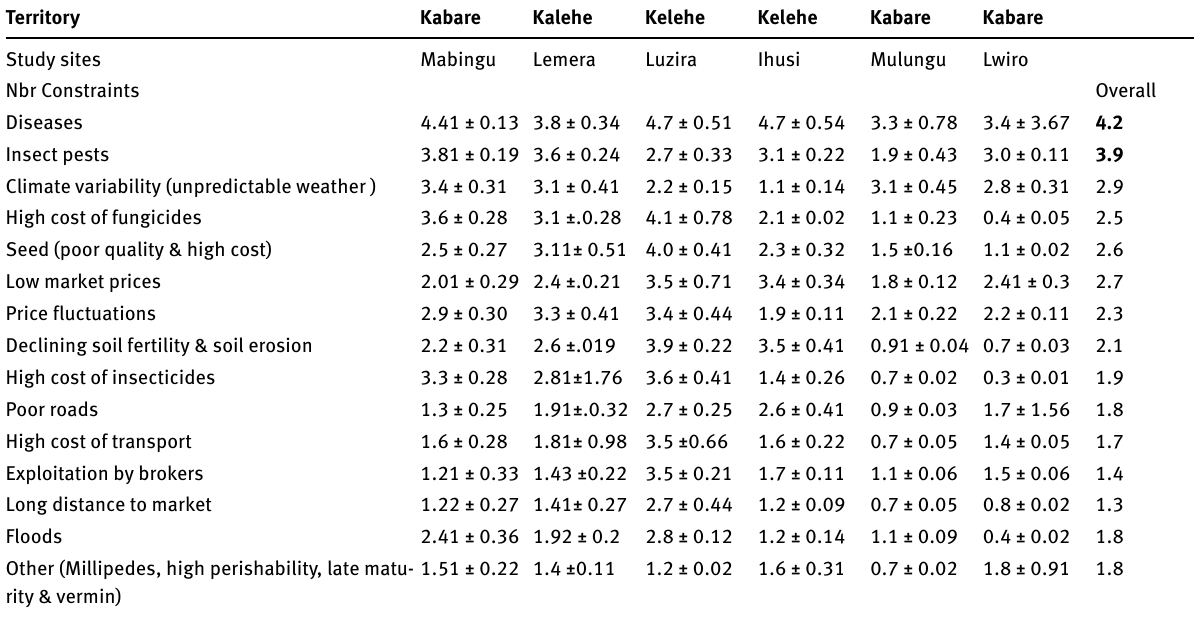
Table 2b: Mean (X±SE) scores of constraints reported by potato farmers in six study sites of Kabare and Kelehe territories, South-Kivu Pro- vinces, eastern DRCongo (2016 survey; N =